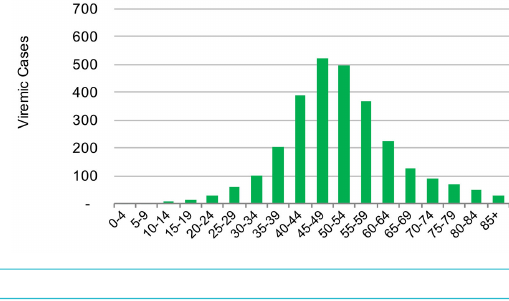
Figure 1: Age and sex distribution of hepatitis C cases in the can- ton of St Gallen in 2015.